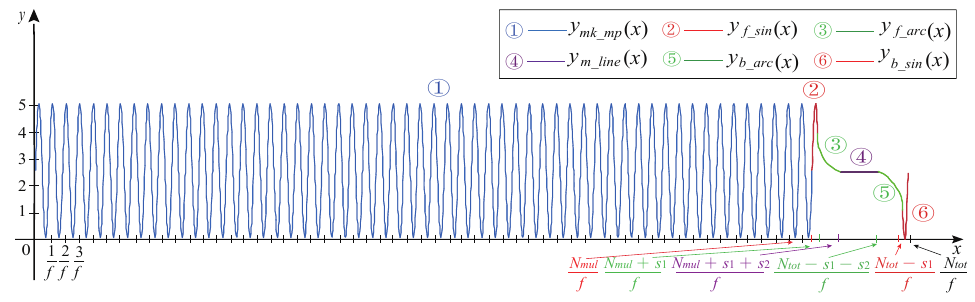
Figure 11. Missing teeth magnetoelectric CKP signal.